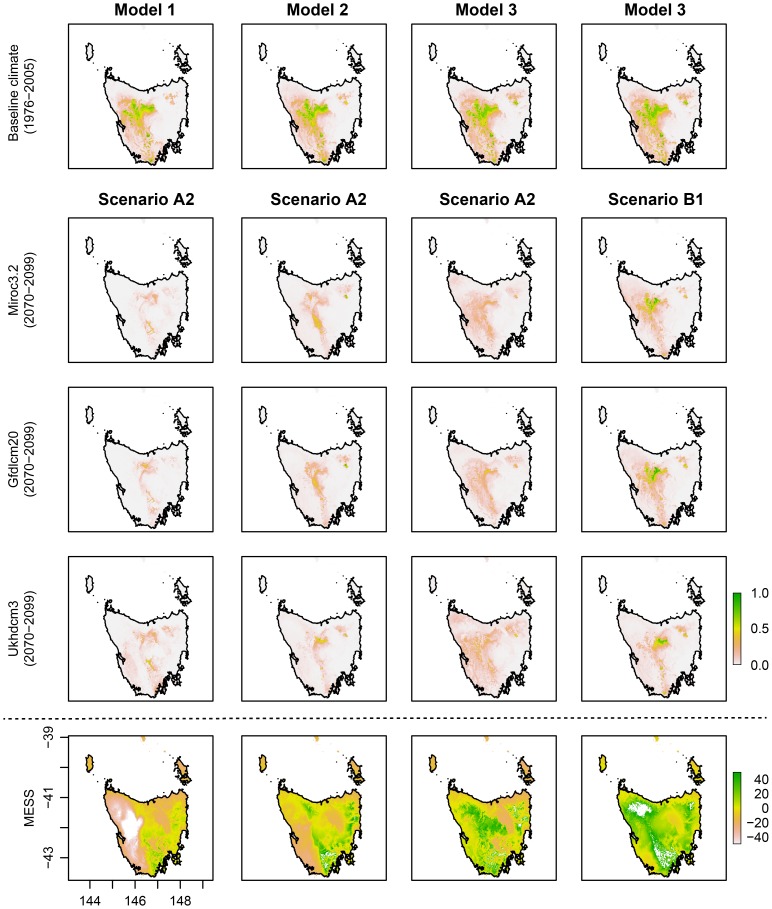
Distribution maps for King Billy Pine using baseline climate data (Row 1) and climate projections from three global circulation models (GCMs) for the period 2070–2099 (Rows 2–4) using two CO2 emissions scenarios: A2 for Models 1 to 3 (Columns 1–3) and B1 (Column 4, only for Model 3).